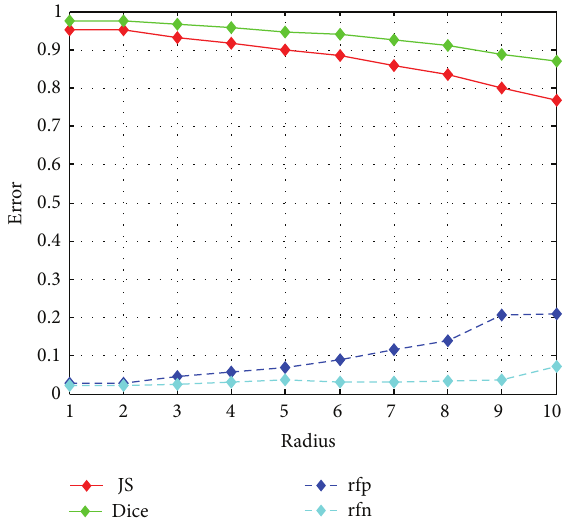
Figure 12: Errors for the segmentations in Figure 11, that is, the JS, Dice, rfp, and rfn with different radius